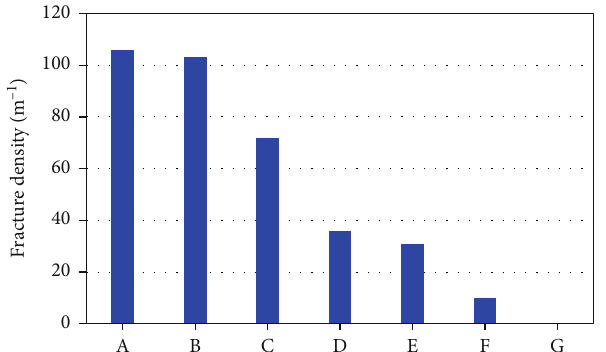
Figure 12: Density of lamellation fractures in di ff erent lithofacies in the Qianjiang Depression ( N = 829 ). A: carbonaceous bedded argillaceous dolomite; B: carbonaceous laminated dolomite or calcareous mudstone; C: carbonaceous glauberite- fi lled laminated argillaceous dolomite; D: carbonaceous massive argillaceous dolomite; E: carbonaceous massive mudstone; F: carbonaceous dolomite or argillaceous glauberite; G: